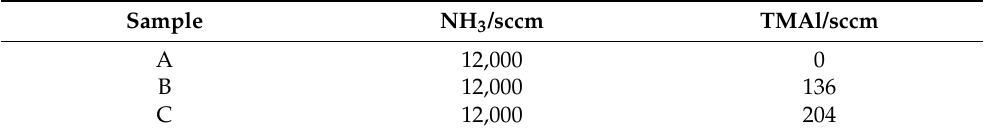
Table 1. The source flow rate of NH 3 and TMAl at the initial 1 min before the HT AlN layer growth.